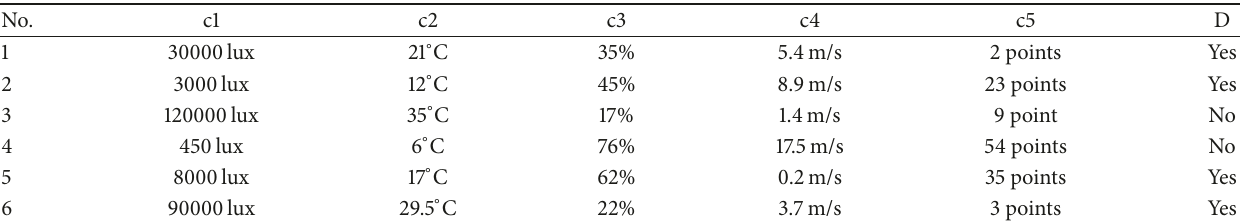
Table 1: Weather information table.